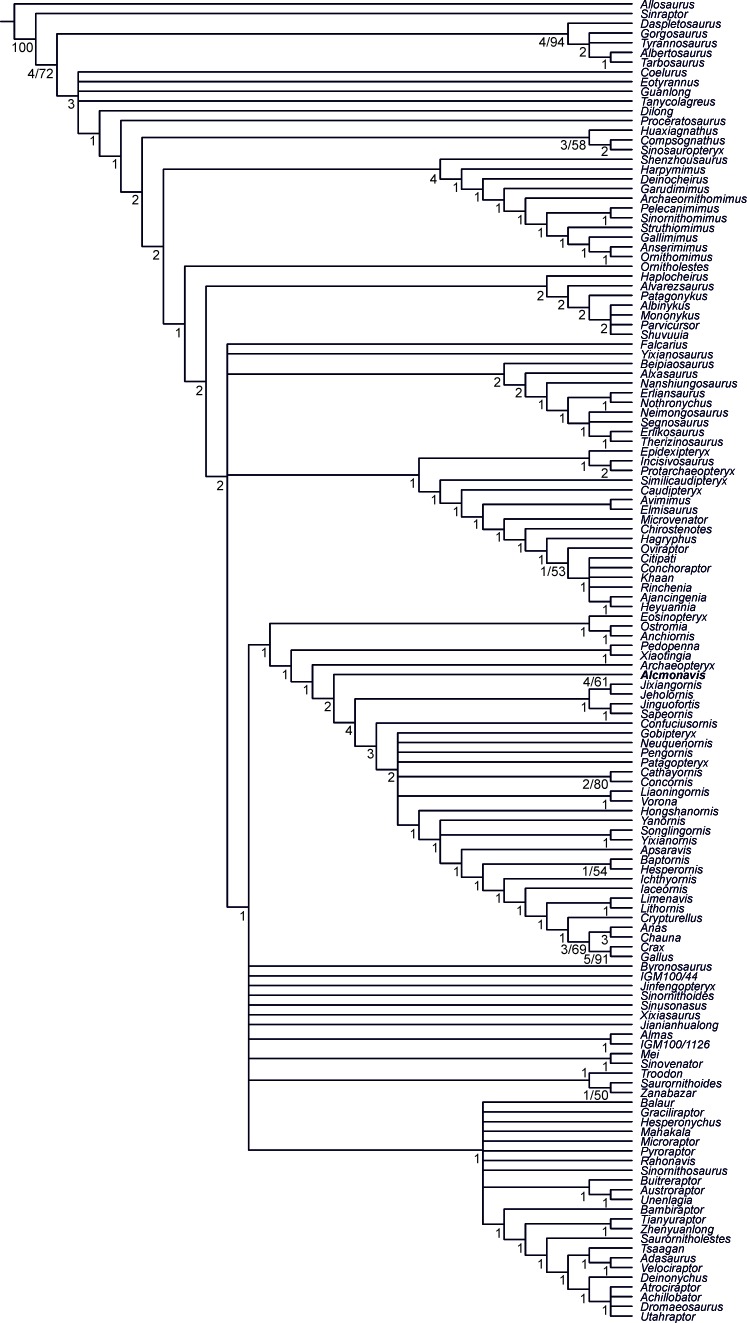
Full strict consensus tree of the unweighted analysis with Bremer support and Bootstrap values for clades with a support of 50% or more indicated.